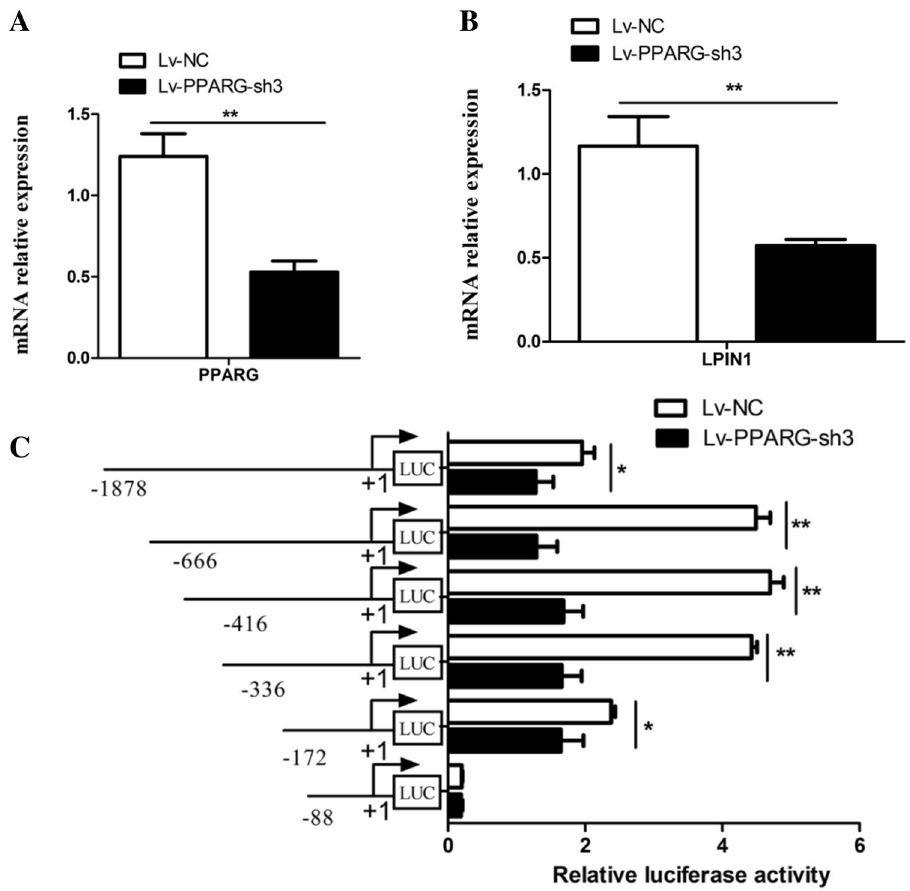
Figure 7. Effects of PPARG knockdown on LPIN1 promoter activity in the BMECs. ( A ) The mRNA expression of PPARG after treatment with Lv-PPARG-sh3; ( B ) The mRNA expression of LPIN1 after treatment with Lv-PPARG-sh3; ( C ) Relative luciferase activity (Firefly: Renilla) of 5’ flanking deletion constructs (− 1878 bp/ + 42 bp, − 666/ + 42 bp, − 416/ + 42 bp, − 336/ + 42 bp, − 172/ + 42 bp and − 88/ + 42 bp). Values are provided as mean ± SEM; *, P < 0.05; **, P < 0.01.